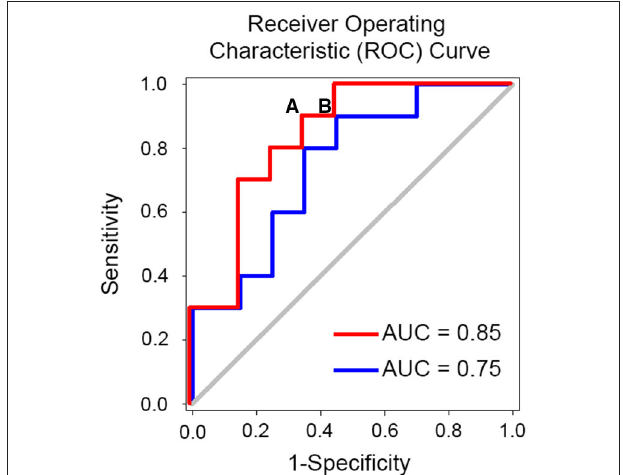
FIGURE 3 | Example of simulated receiver operating characteristic curve (ROC) and identification of optimal cut-off point for decision. An optimal cut off for predicting the success of spine surgery would minimize the false negative rate (i.e., patients who would benefit from the surgery but end up not having it) and minimize the false positive rate (FPR) (i.e., patients who would not have the surgery and end up having it). Note that the false positive rate is equal to 1-specificity and is depicted on the x-axis in the figure. If we consider point (A) on the red curve, we will have a biomarker with 90% sensitivity and 34% FPR or 66% specificity. Given that 60% of patients undergoing spine surgery are expected to benefit from it our theoretical biomarker will miss 10% of these patients and hence 6 patients for each 100 patients. Also, given an expected 40% failure rate we expect that ∼ 26 patients will not undergo the surgery anymore. In total, 32 patients who would otherwise undergo surgery without a biomarker-based work-up end up triaged to the no surgery options. If instead we consider point (B) , we will have a biomarker with 90% sensitivity and 45% FPR. Following the same calculation 28 patients who would otherwise undergo surgery without a biomarker-based work-up end up triaged to the no surgery options. Abbreviation: AUC, area under the